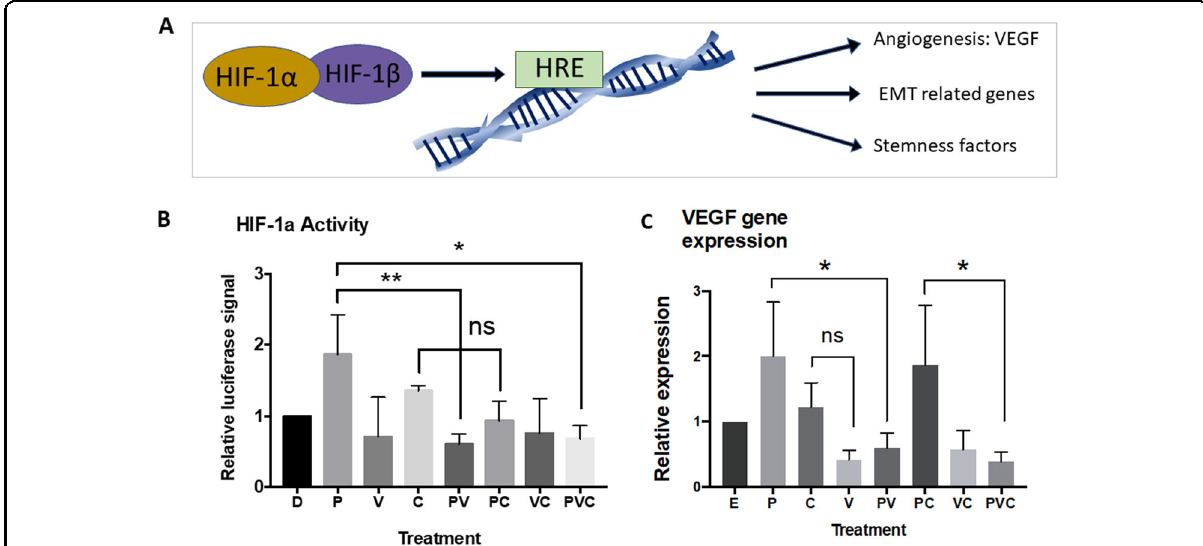
Fig. 4 Vertepor fi n-NP also inhibits angiogenesis-associated genes in vitro in human TNBC cells. A Schematic showing that HIF-1 α is a master regulator in angiogenesis and other tumorigenic processes. B Luciferase reporter activity of HIF-1 α activities in MDA-MB-231 cells treated with control DMSO, paclitaxel (25 nM), vertepor fi n (1.25 µM), CA4 (25 nM), and different combinations for 24 hrs. C RT-qPCR analysis showing the changes of VEGF gene expression in MDA-MB-231 cells after 24 hrs of treatment with E (empty-NP), 25 nM P (paclitaxel-NP), 1.25 µM V (vertepor fi n-NP), 25 nM C (combretastatin-NP), and different combinations. Data are expressed as mean ± SD, n = 3. * P < 0.05, ** P <